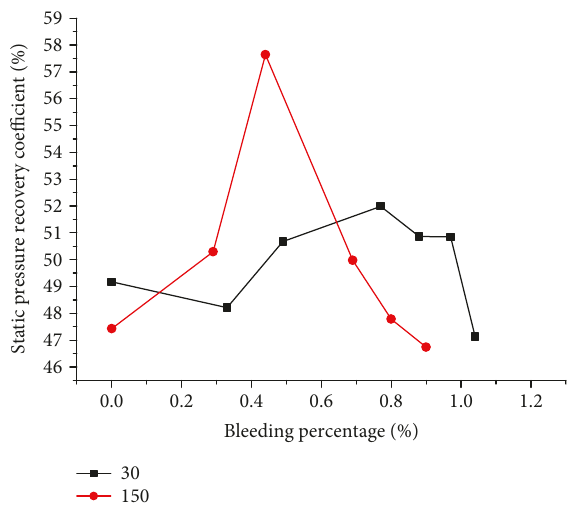
Figure 18: Relationship between the static pressure recovery coe ffi cient and the bleeding percentage (1.73 expansion